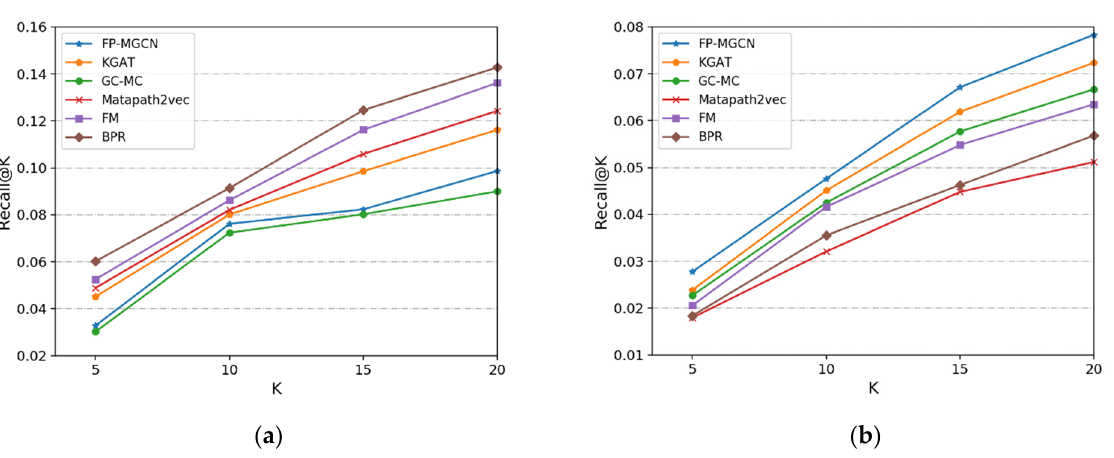
Figure 3. The results of Recall@K on two datasets. ( a ) Recall@K on Dianping; ( b ) Recall@K on Yelp.